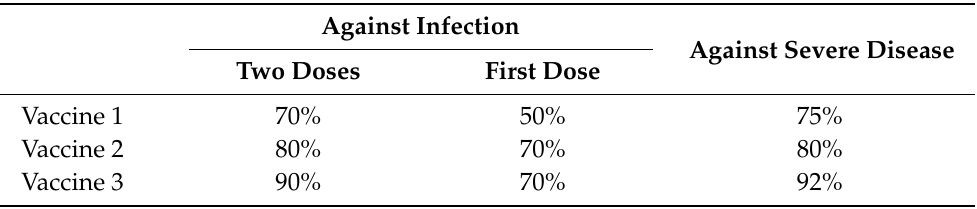
Table 1. Vaccine efficacy. Three considered vaccine’s first and two-dose efficacy against infection and against severe